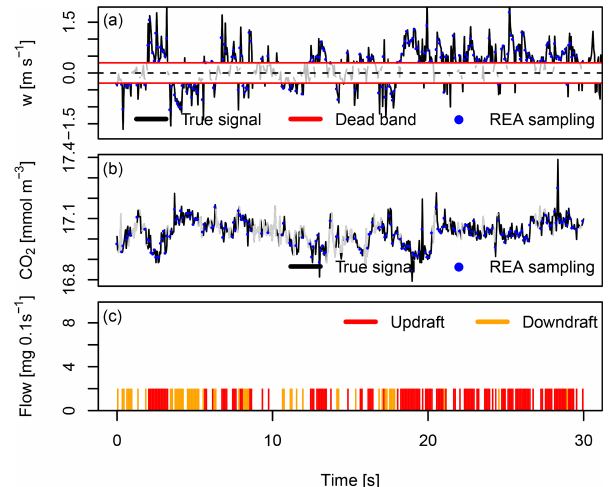
Figure 2. Relaxed eddy accumulation sampling scheme. Vertical wind, w (a) , scalar density, CO 2 (b) , and mass flow rate (c) . Black solid lines indicate the continuous true atmospheric signal. Sam- pling resolution of REA is 10Hz. A fraction of the CO 2 time series (gray lines, b ) is not sampled by REA due to use of a vertical wind velocity dead band for small velocities (thresholds indicated by red lines, a ). This dead band causes gaps in the otherwise constant mass flow rate (c)